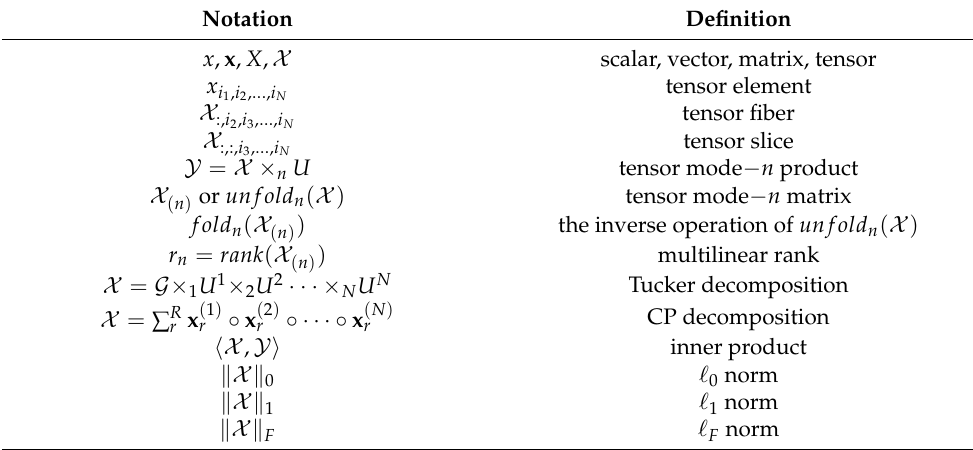
Table 1. Tensor notations and